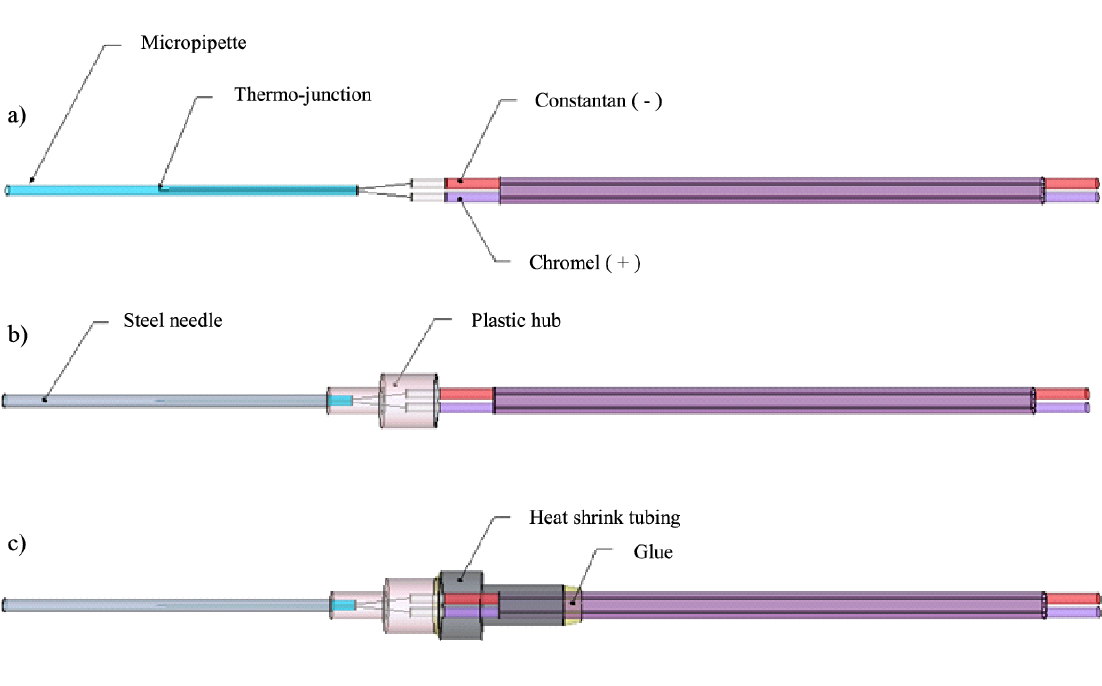
Figure 2. ( a ) Temperature probe schematic of thermo-junction location inside the micropipette and connection to Type E thermocouple extension wire (constantan/chromel). ( b ) Temperature probe schematic showing micropipette located inside the steel